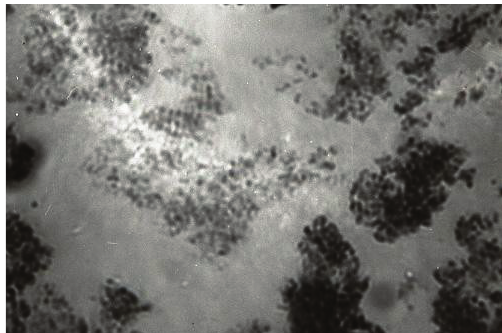
Figure 1: 2𝑛 = 6𝑥 = 42 chromosomes belonging to sample 504K of P. pseudo orientale collected from Dibekli koprusu, Van Turkey pretreated with 𝛼 -monobromonaphthalene for 45 minutes.